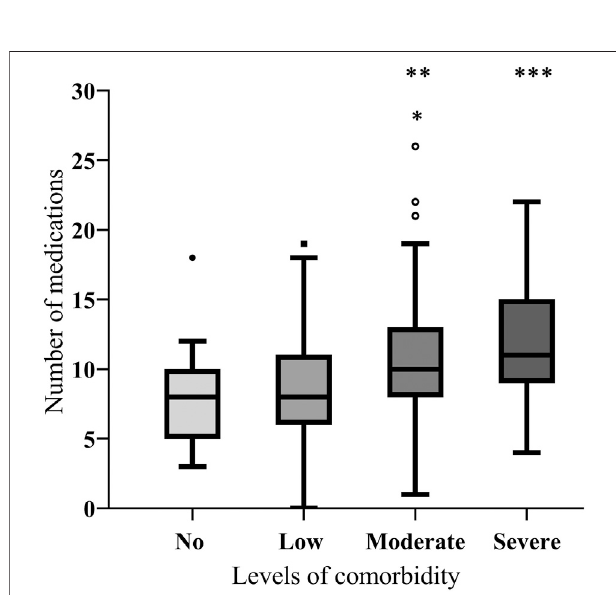
FIGURE 4 | Boxplot diagram: Number of prescribed drugs grouped by different comorbidity levels.* p < 0.05 vs. no comorbidity; ** p < 0.01 vs. low comorbidity;*** p < 0.001vs.lowcomorbidity;*** p < 0.001vs.nocomorbidity.